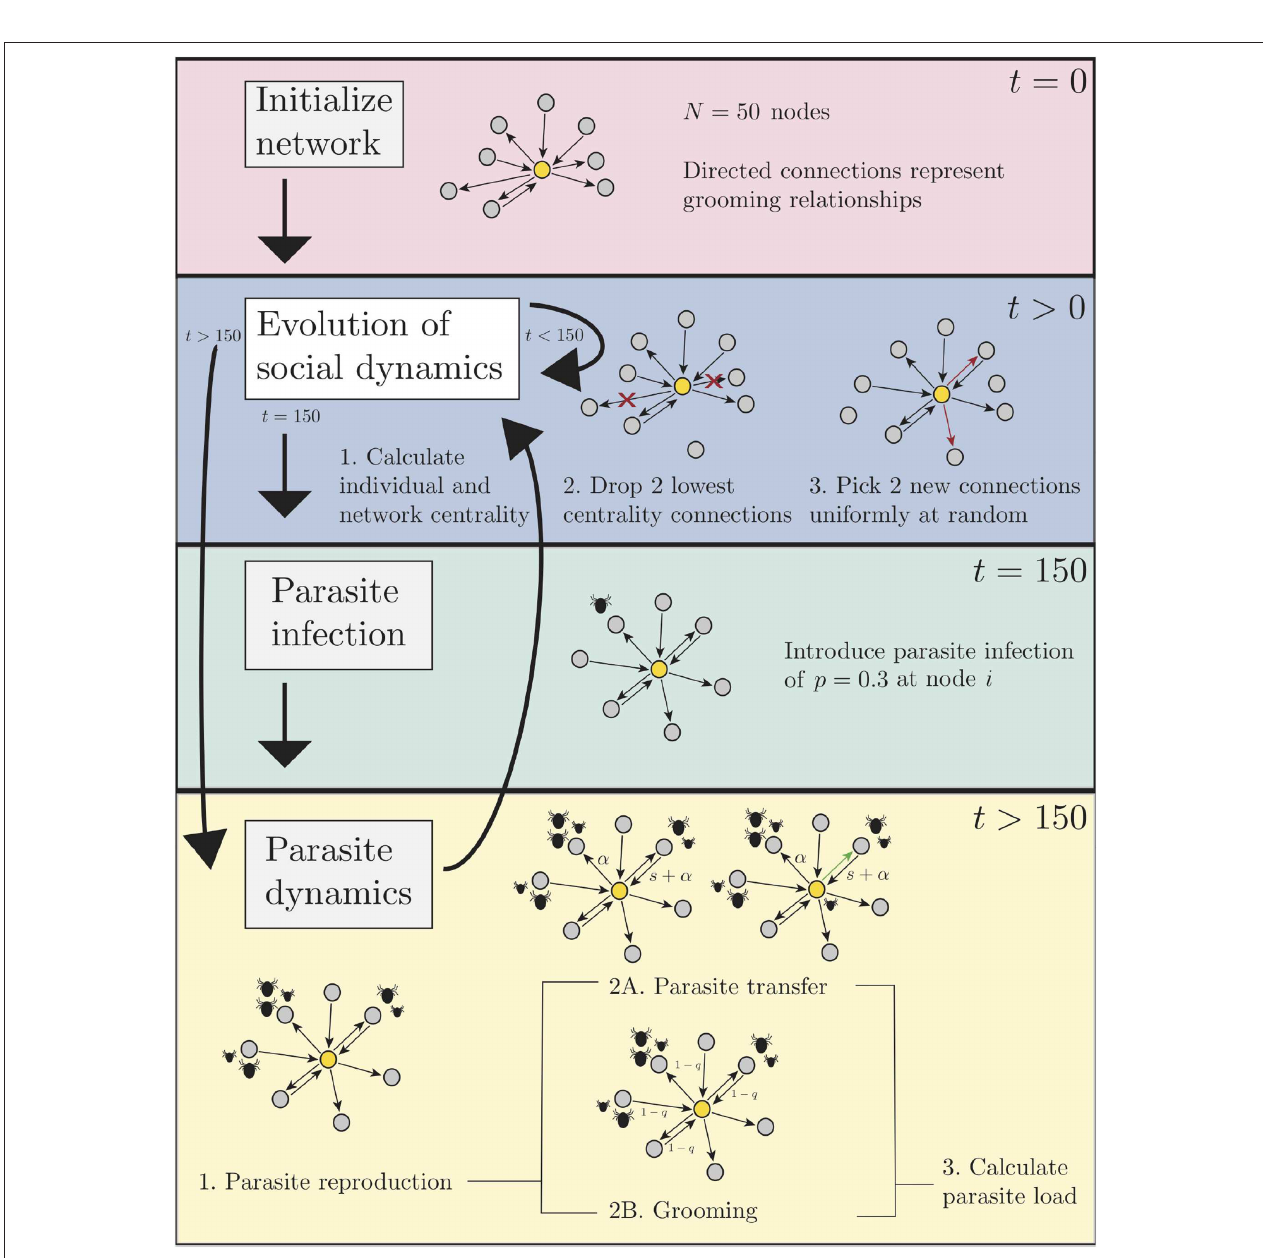
FIGURE 1 | A schematic of our ectoparasite spreading algorithm as described in section 2. The four primary components of the algorithm are network initialization (pink section), network dynamics (blue section), ectoparasite infection (green section), and ectoparasite dynamics (yellow section). Ectoparasite dynamics include reproduction, grooming, and transmission. Pseudocode for the algorithm is available in Appendix A